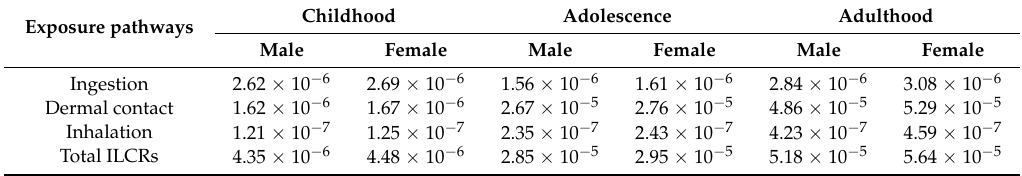
Table 4. Incremental Lifetime Cancer Risks (ILCRs) of people for different exposure pathways.